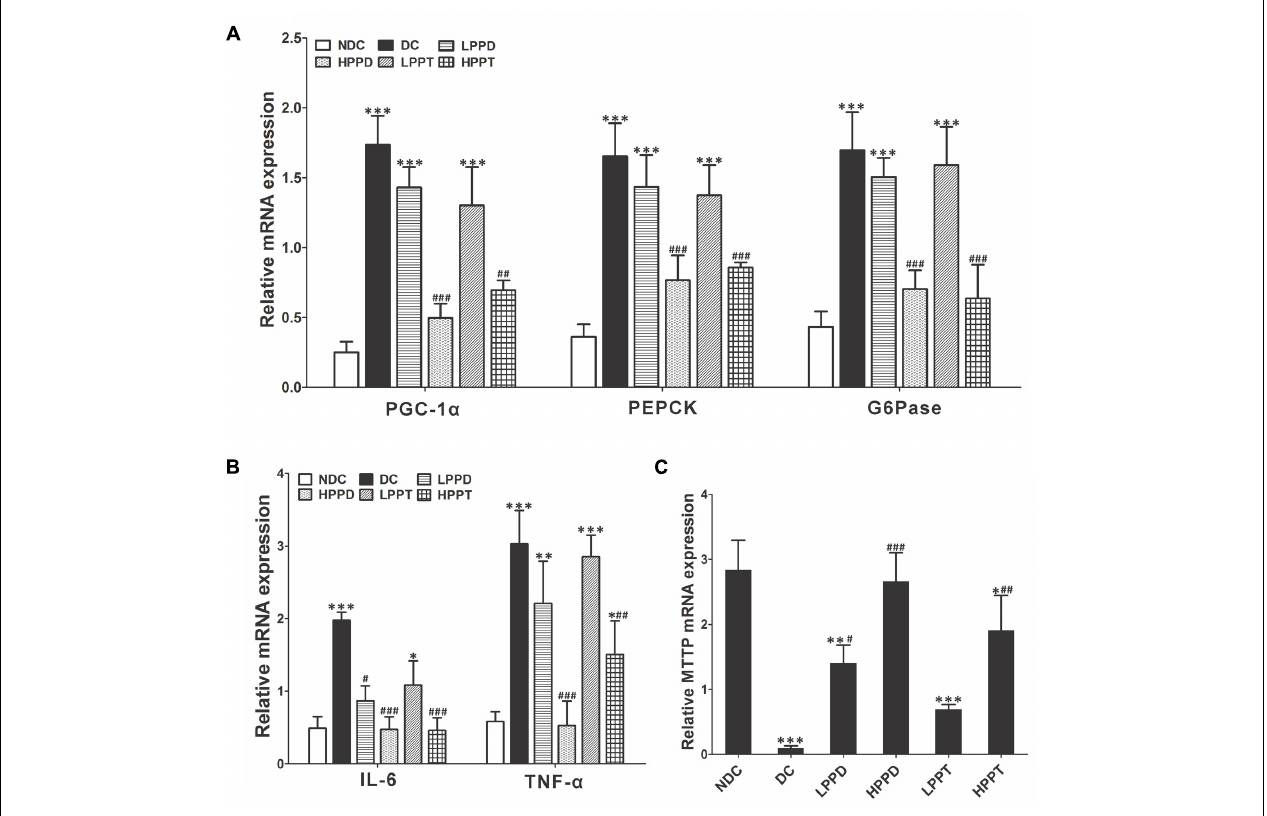
FIGURE 8 | Effects of PPD and PPT in liver of relative mRNA expressions of (A) PGC-1 α , PEPCK, G6Pase, (B) TNF- α , IL-6, (C) MTTP in high-fat and STZ-induced diabetic mice; ∗ p < 0.05, ∗∗ p < 0.01, ∗∗∗ p < 0.001 vs. NDC group, # p < 0.05, ## p < 0.01, ### p < 0.001 vs. DC group. Different groups were significantly different ( p <